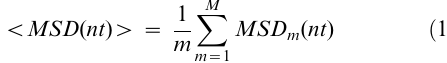
Figure S1 Cumulative frequency histograms of fluores- cence intensities of single sAv-QD525, sAv-QD585, sAv- QD625, and AMP-QD800. Cumulative frequency histo- grams of the background subtracted fluorescence inten- sities per pixel of 9 6 9 pixel arrays of identified single QDs in absence of DTT (left), and in presence of 1 mM DTT (right). These histograms were generated from 3 fields of view in total containing between , 100 # n # , 600 single QDs that were each imaged for m= 300 image frames. The total sampling points for each histogram (m n) were , 30,000 # m n # , 180,000. The mean fluorescence intensities, I QDon , and fractional intermit- tency times, F QDon , were determined by non-linear curve fitting (red dashed line) as described in the Methods section. Figure S2 QuadView microscope filter configuration. Parallel multi-color single QD measurements were acquired using a QuadView image splitter (Bio-Science Aps, Gilleleje, Denmark) with dichromatic mirrors Q585LP, Q630LP and Q690LP and with D565/40 m, D605/20 m, and D655/20 m fluorescence bandpass filters from Chroma Technologies (Rockingham, Vt, USA). All imaging was done on an Andor DV887-ECS/BV EMCCD (Belfast, Northern Ireland). The quantum efficiency (QE, dashed line) of this camera according to the technical specifications of the manufacturer is approximately independent of the wavelength over a spectral range of , 500– , 670 nm, with an approximate decrease of 5% at 700 nm, and about 25% at 800 nm. The emission spectra of sAv-QD565 (orange line), QD605 (red line), QD655 (dark red line), and QD705 (black line) were acquired on a NanoDrop 3300 Fluorospectrometer (Saveen & Werner, Limhamn, Sweden). Figure S3 Representative fluorescence intensity time traces of single sAv-QD525, sAv-QD585, sAv-QD625, and AMP-QD800. Representative, background subtracted, integrated fluorescence intensities, as a function of time, of identified single QDs that had been absorbed non-specifically to a glass coverslip in the absence of DTT (left) and in the presence of 1 mM DTT (right). Images of QDs with different peak emissions were acquired under identical conditions with continuous blue illumination with 5 ms integration at a frame rate of , 25 Hz for 300 image frames. Also shown are the fluorescence intensity fluctuations of the background (grey lines). Figure S4 Localization precision of single sAv-QD525, sAv-QD565, sAv-QD585, sAv-QD605, sAv-QD625, sAv- QD655, QD705, and AMP-QD800: The localization precision of single QD imaging with 5 ms camera integration times was determined by time-lapse imaging and SPT analysis of QDs